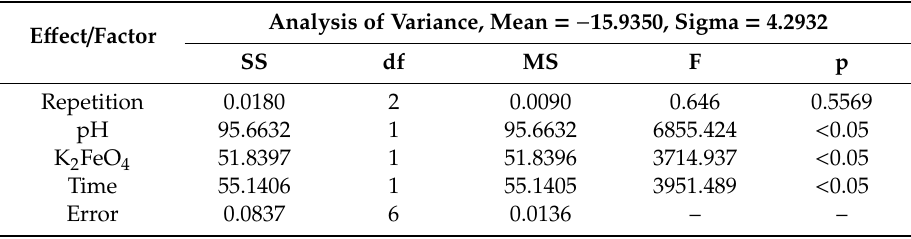
Table 4. Analysis of experiment (ANOVA) by using Statistica 13.